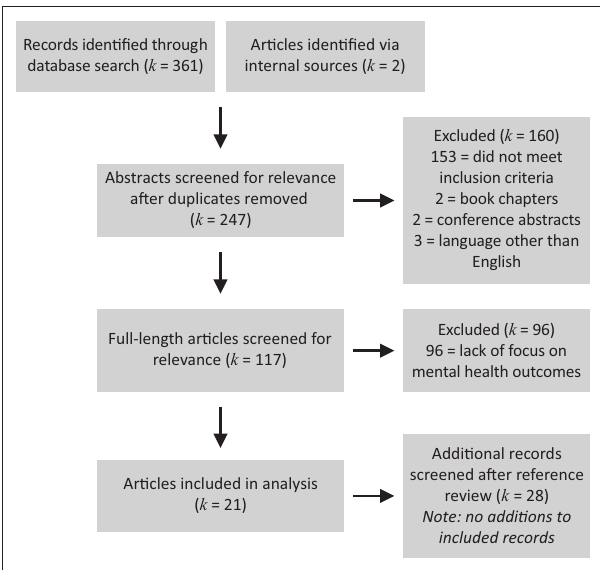
FIGURE 1: PRISMA diagram for the identification of